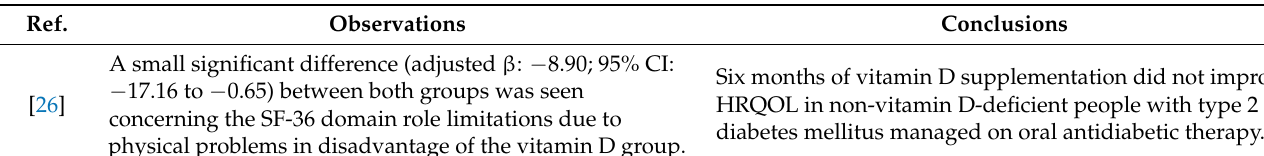
Table 5. The findings presented within the studies included to the systematic review.